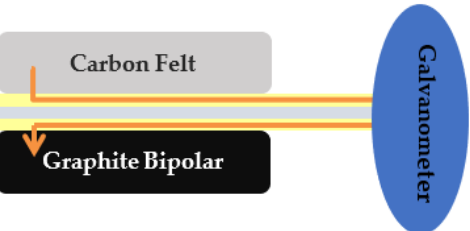
Figure 6. Schematic diagram of micro current sensor operating principle.